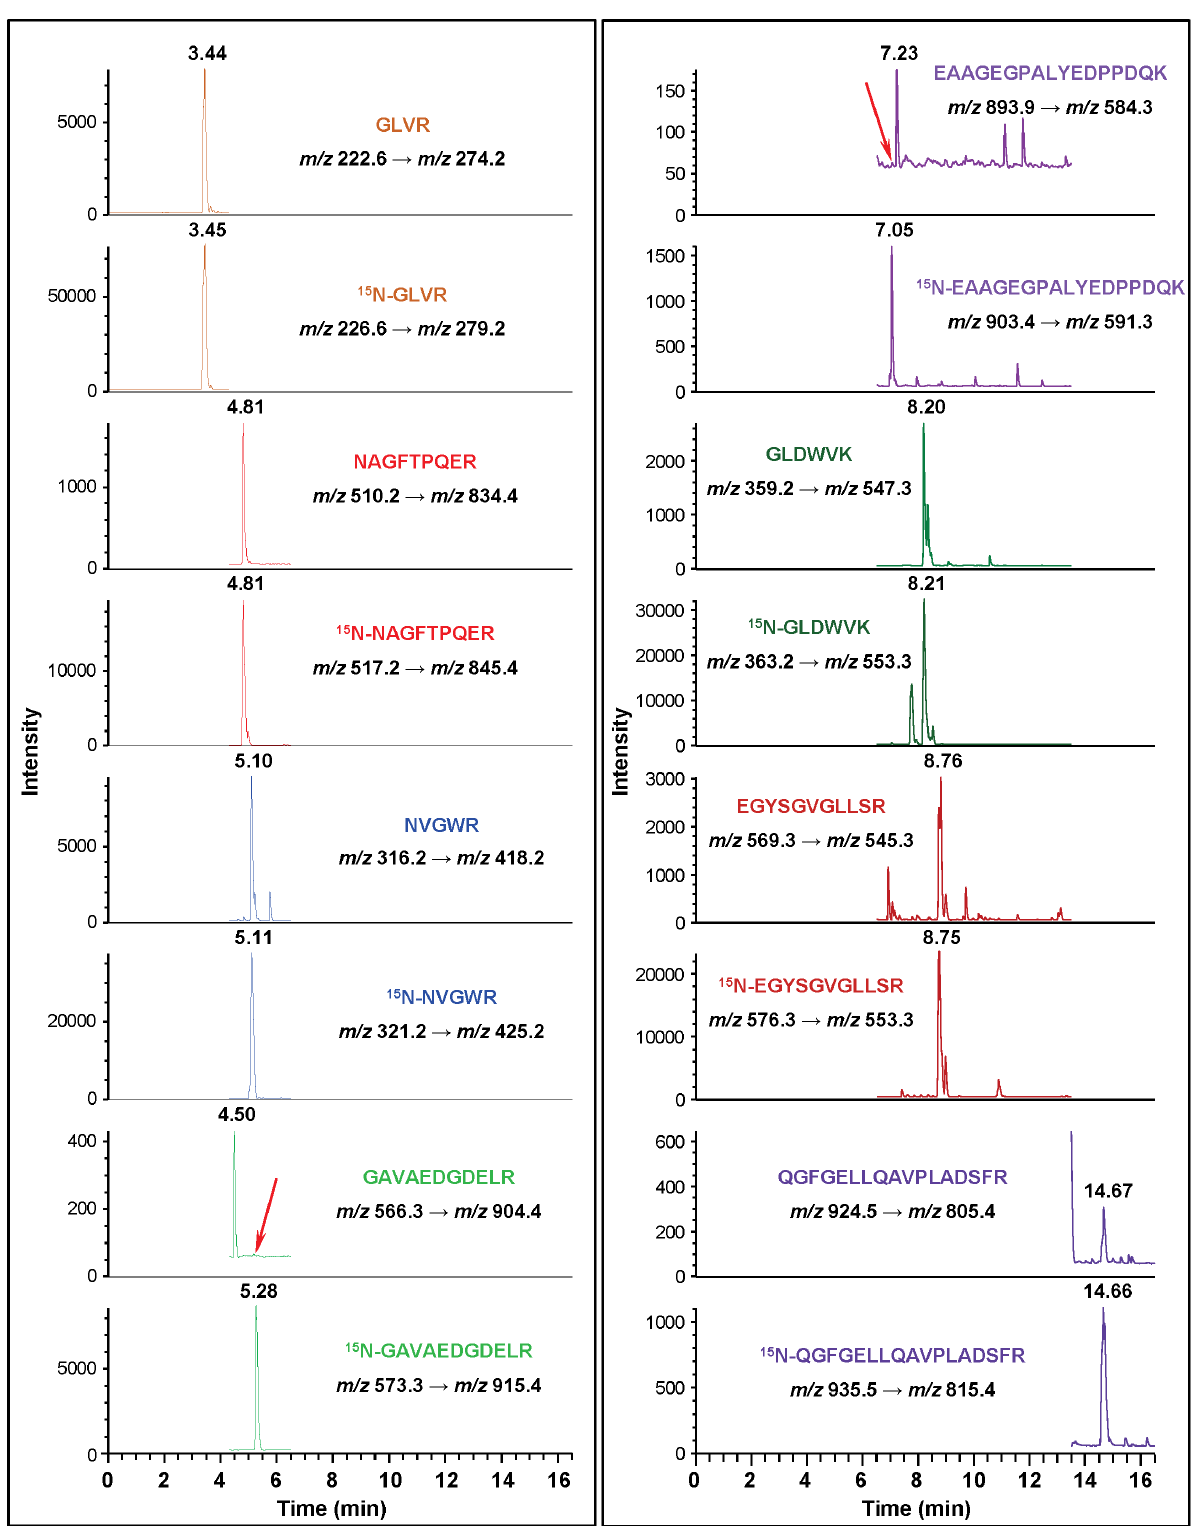
Figure 6. Ion-current profiles of mass transitions of eight tryptic peptides of hAPE1 and 15 N-hAPE1 obtained using the tryptic hydrolysate of a protein fraction, which was collected during separation by HPLC of a nuclear extract of mouse liver. The nuclear extract was spiked with an aliquot of 15 N-hAPE1 prior to HPLC-separation. Peptides and monitored transitions are shown. The red arrows indicate the elution positions of GAVAEDGDELR and EAAGEGPALYEDPPDQK, which are absent, because they are not among the tryptic peptides of mAPE1.